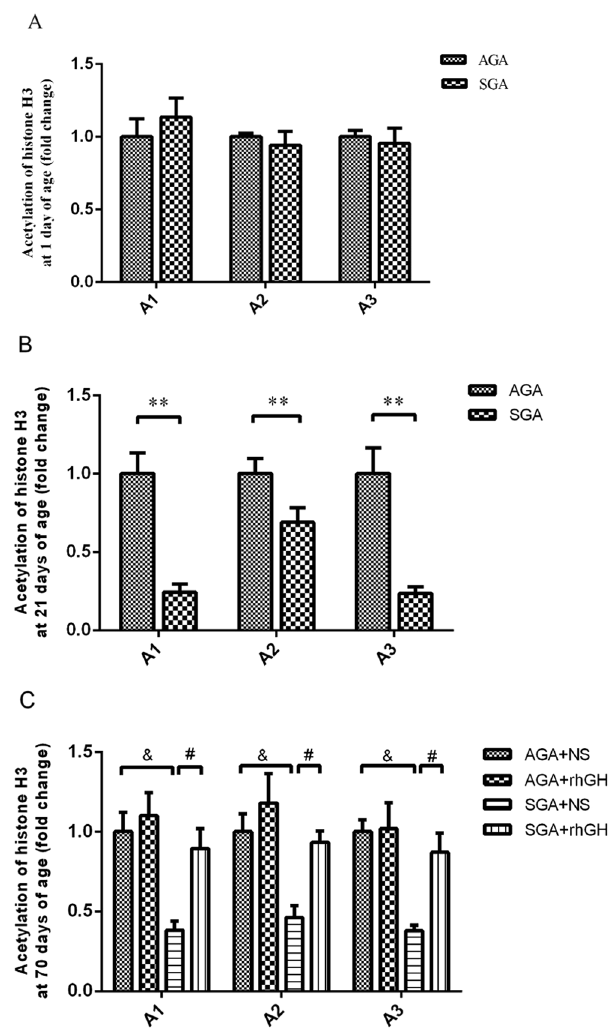
Acetylation of histone H3 at neonatal ( A ) adolescent ( B ) and adult ( C ) periods. Quantification was performed using real-time PCR with primers specific to the proposed AMPK- α 1 element sites (A1: − 449 to − 640; A2: − 887 to − 1099; A3: − 1330 to − 1526). Statistical differences between the groups are given as follows: ** p < 0.01: AGA vs SGA; & p < 0.05: AGA + NS vs SGA + NS; # p < 0.05: SGA + NS vs SGA + rhGH. n = 6 per experimental